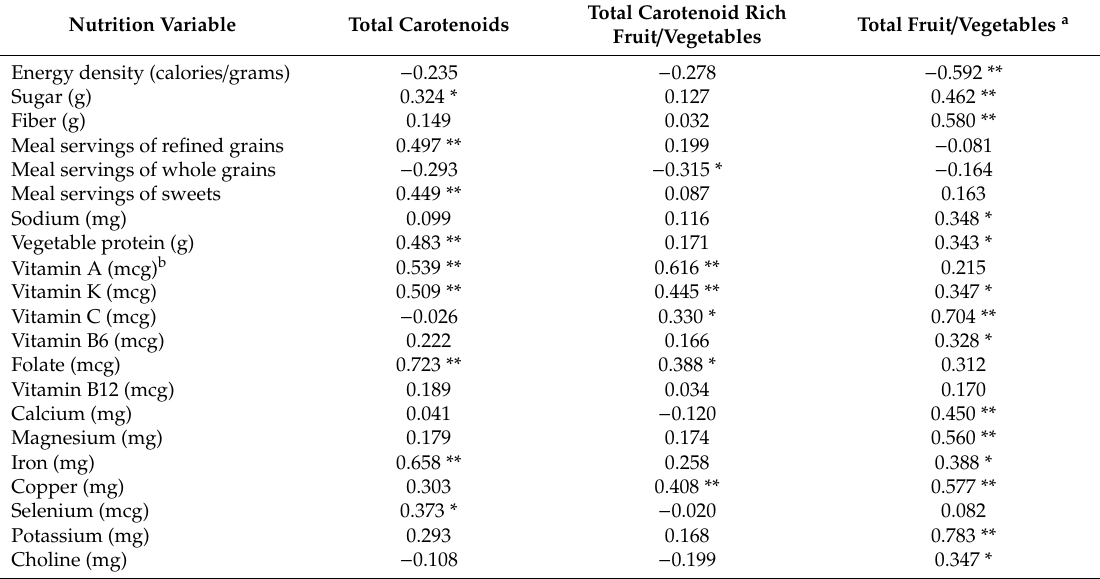
Table 5. Associations between nutrient variables and total carotenoid content, carotenoid-rich fruit / vegetables, and total fruit / vegetables (Pearson